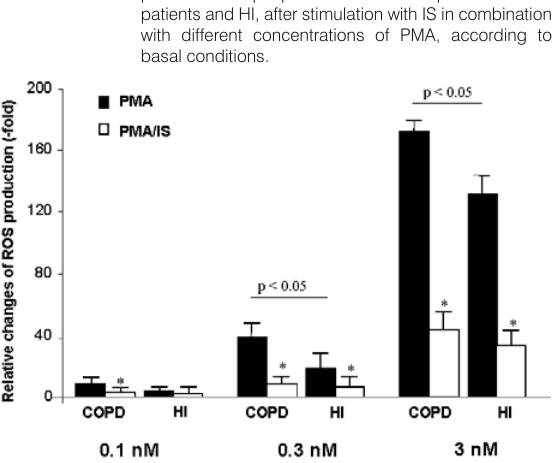
Data are shown as fold changes ±SEM. *p<0.05 compared to PMA alone.